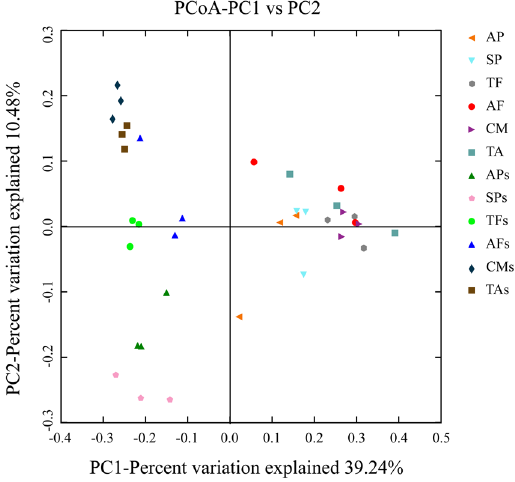
Figure 4. The principal coordinate analysis, namely, PCoA analysis, showed of the bacterial community composition on all analyzed samples at OTU level based on algorithm analysis by weighted_unifrac. The distance between points reflects the differences in bacterial community structure among samples.